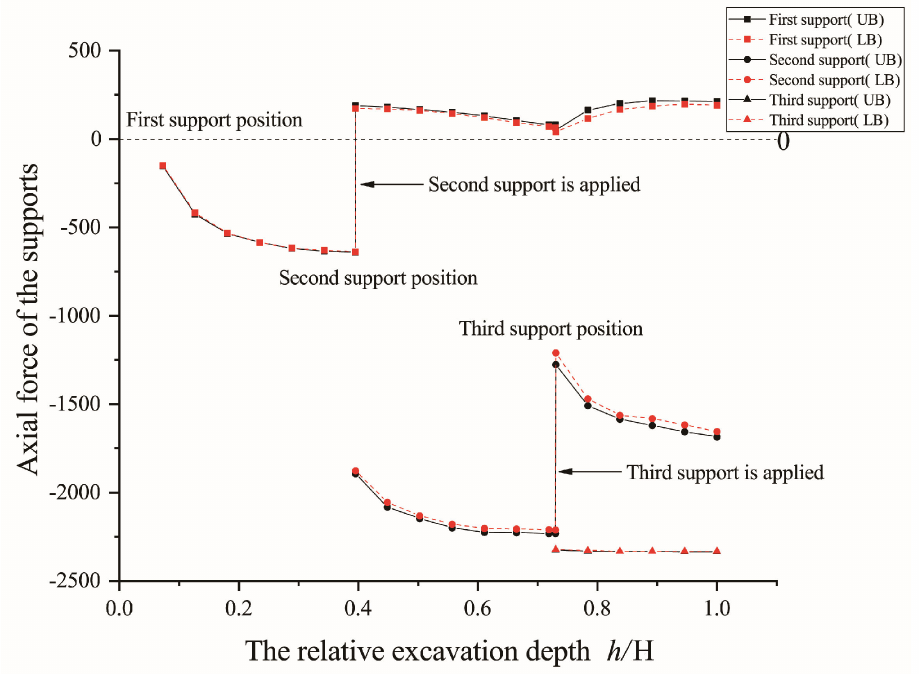
Figure 27. Influence of the relative excavation depth h /H on axial force of the supports of foundation pit.